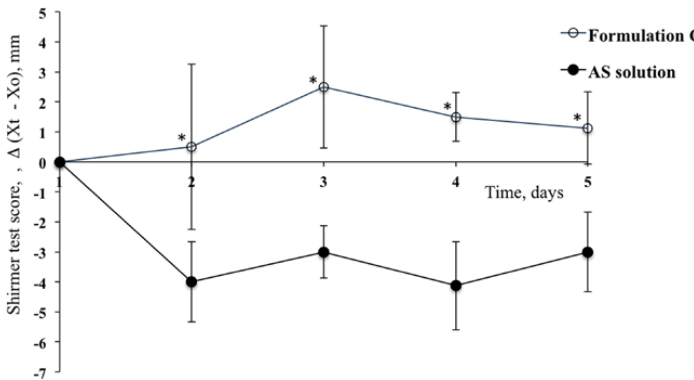
Figure 6. Shirmer Test Scores for the group of rabbits treated with Formulation C and for contralateral eyes (Reference) after treatment with AS solution. (Means ± SE, n = 6). * Statistically significant different from the STS calculated for the contralateral eye ( p < 0.05, t -test).